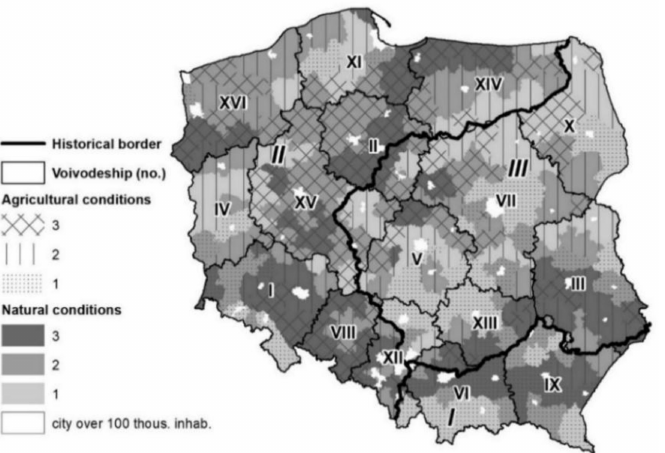
Figure 2. Spatial scope of studies and selected conditions of the development of non-agricultural activities in Poland. Sources: own study. Numbers ascribed according to the alphabetical or- der of voivodeships (voiv.; I – XVI): I—Dolno´sl ˛askie, II—Kujawsko-Pomorskie, III—Lubelskie,